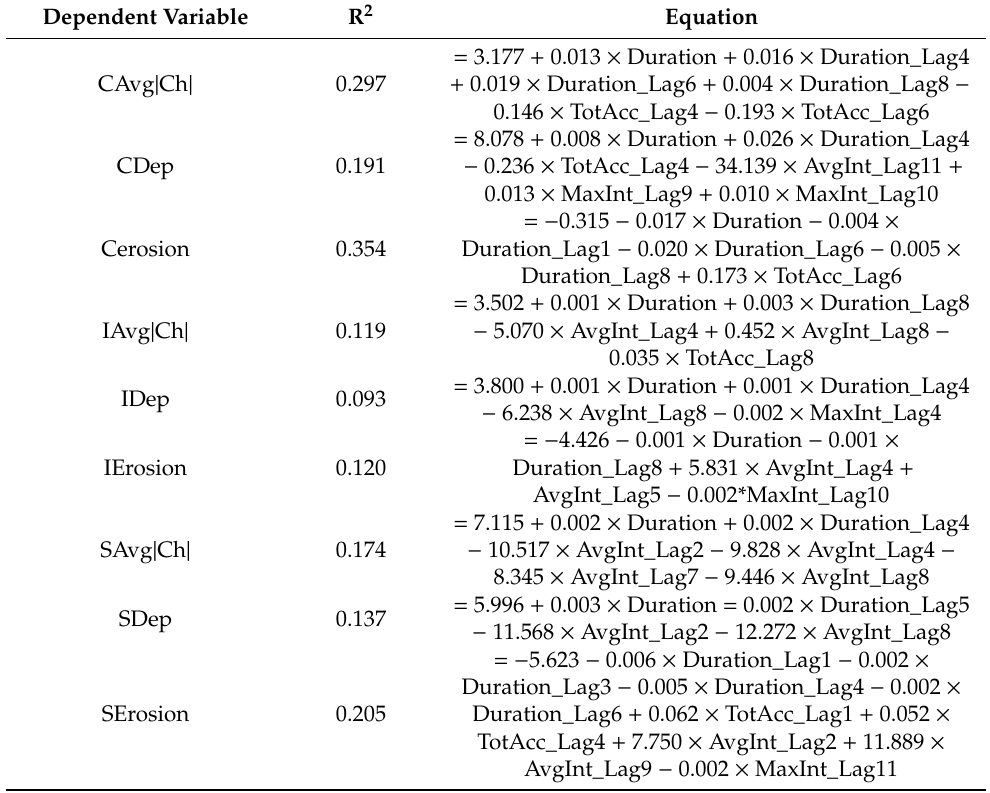
Table A1. Regression equations for erosion variables (dependent variables) using lagged precipitation parameters (independent variables). Lagged variable names are appended with “LagN”, where N indicates the number of measurement periods of antecedent lag. Duration_Lag1 indicates precipitation duration in prior measurement period (Lag of 1